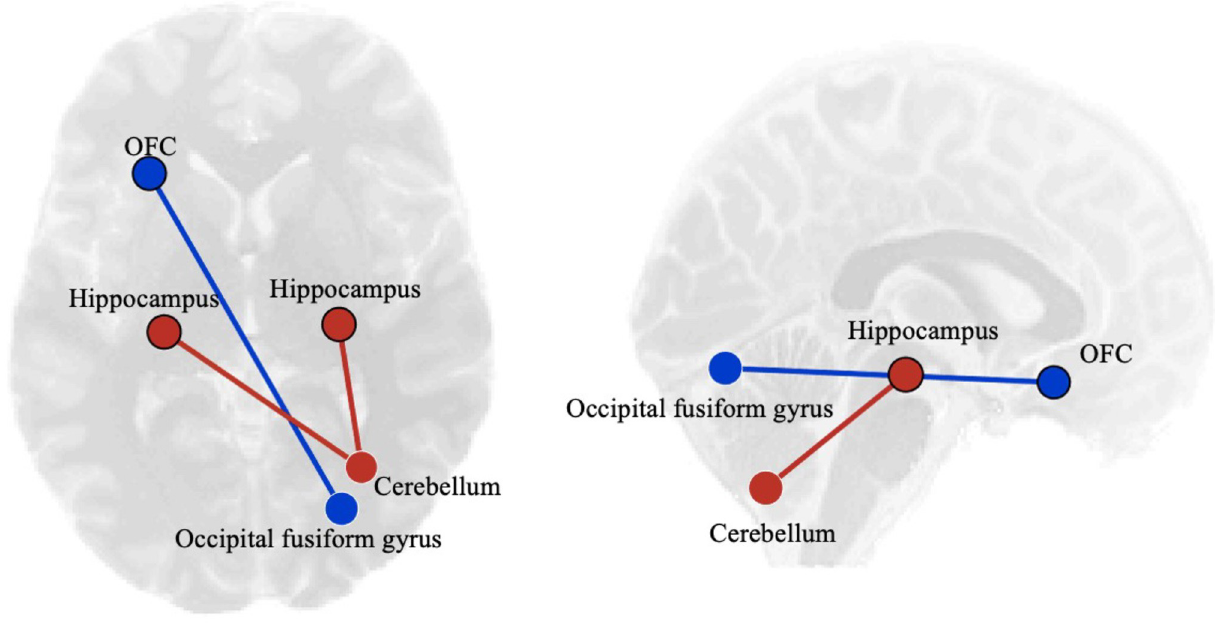
Fig 1. Differences between substance users and non-users showing increases (red) and decreases (blue) in resting state functional connectivity in substance users displayed from an axial view on the left and a sagittal view on the right. See Table 2 for ROI results. L, left; R, right.